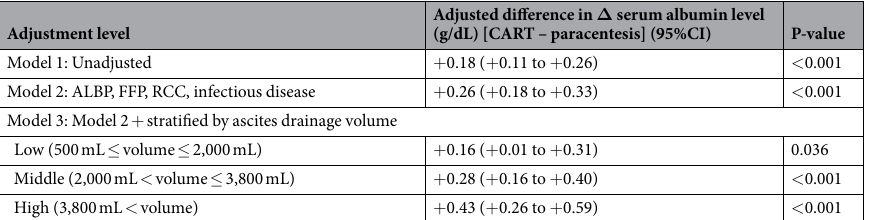
Table 3. Difference in Δ serum albumin level between CART and paracentesis adjusted by multiple linear regression analysis. Δ indicates change from pre-treatment to post-treatment. Multiple linear regression analysis was